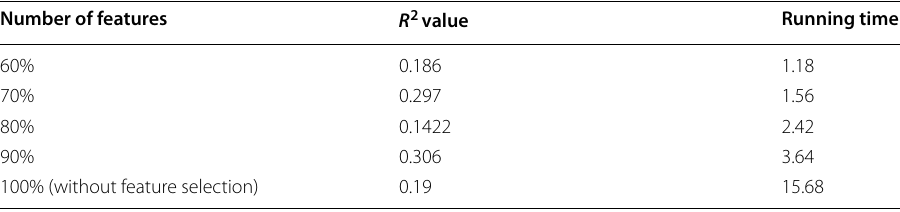
Table 4 QSAR-RFR(PCA) simulation results on FCFP_4 dataset Number of